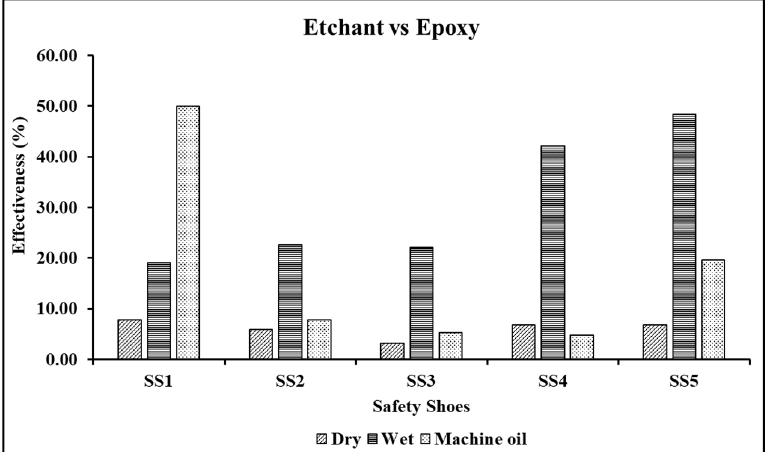
Figure 11. Effectiveness improvement of epoxy-based coating as compared to etchant-based flooring across dry, wet, and machine oil contaminant conditions.